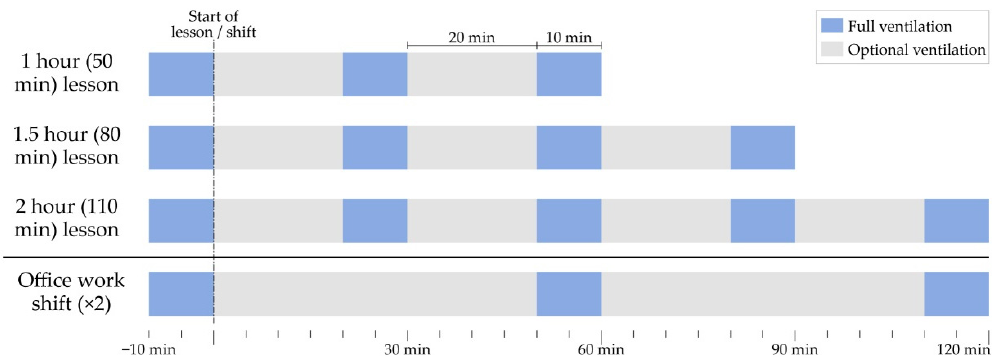
Figure 1. UPV-EHU minimum natural ventilation protocol for classrooms, seminars, laboratories, workshops and office spaces. Source: authors.